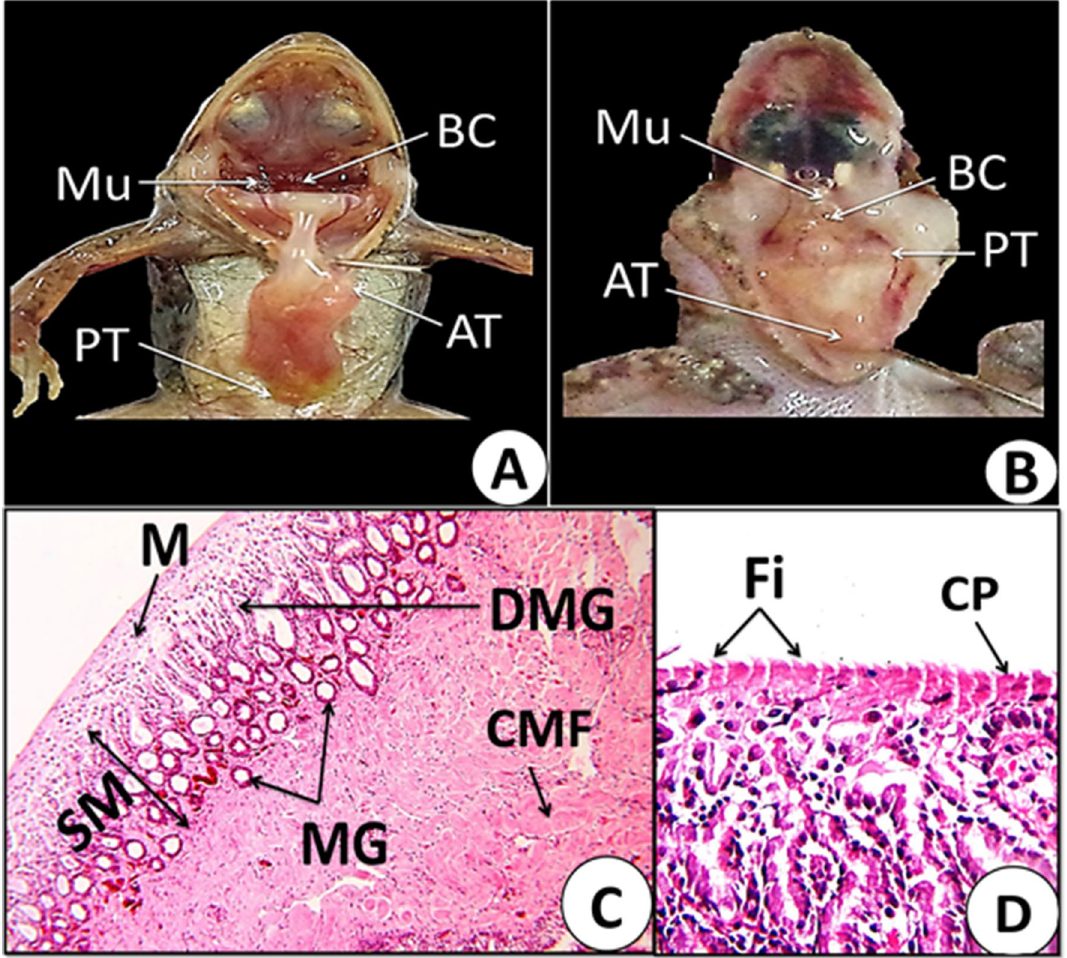
Fig. 1 A A photomicrograph to show the anterior and posterior parts of the tongue (AT & PT); buccal cavity (BC) of Ptychadena mascareniensis filled with mucus (Mu), B The buccal cavity (BC) of Hemidactylus turcicus filled with mucoid secretions (Mu) and showing the anterior and posterior parts of the tongue (AT & PT); C a photomicrograph of a longitudinal section of the middle region of the tongue of P. mascareniensis stained with H & E showing mucosa (M), submucosa (SM), mucous glands (MG) and their ducts (DMG) and circular muscle bundles (CMB), X 100; D , a photomicrograph of a longitudinal section of the posterior region of the tongue of P. mascareniensis stained with H & E showing keratinized filiform papillae (Fi) and cuboid (CP) papillae on the mucosa (M), X